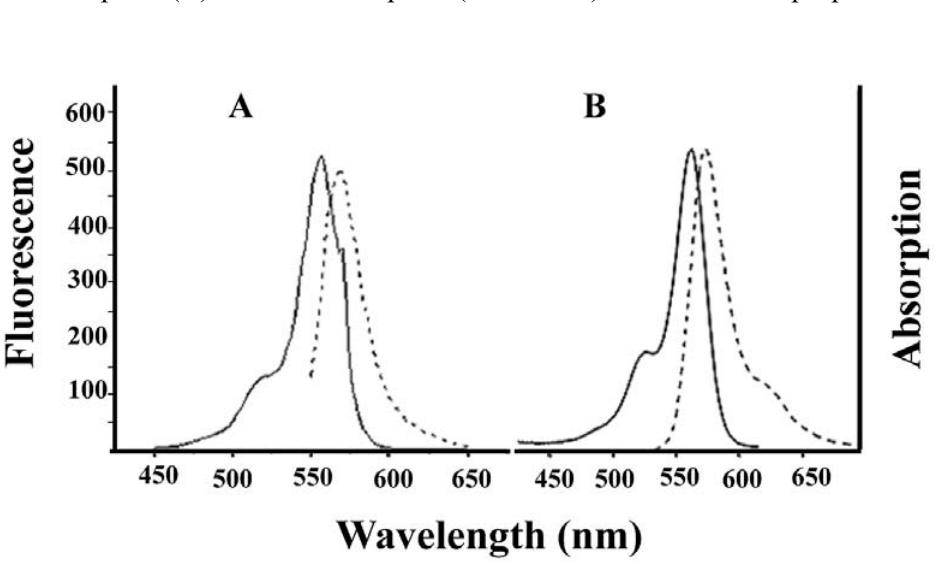
Figure 4. Absorption (solid line) and emission (broken line) spectra of Alexa-Fluor 546 (A) and Alexa-IpTxa (B). Unmodified IpTxa (not shown) lacks emission